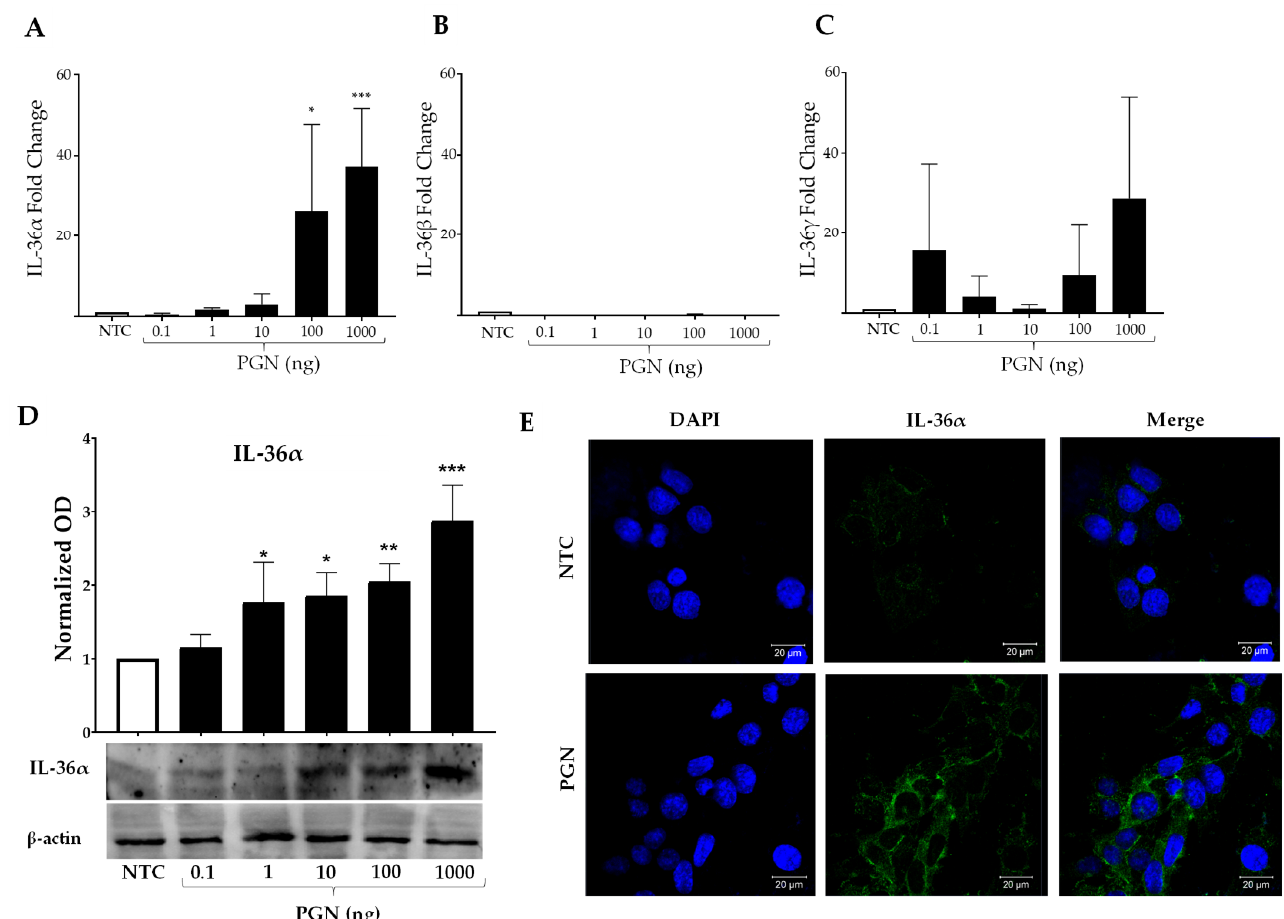
Figure 3. The stimulation of MCs with PGN generates the production of IL-36 α . MES SV40 cells (1.5 × 10 6 ) were stimulated in 2 mL of medium containing different amounts of PGN for 6 h, and ( A ) the IL-36 α ; ( B ) IL-36 β ; ( C ) IL-36 γ mRNA expressions were measured. The expression was normalized against Actb, and the fold change was calculated in comparison with the respective non-stimulated control (NTC). ( D ) Mesangial cells were stimulated under similar conditions, and total proteins were extracted for WB. The intensity of bands was normalized against β -actin, and the fold change was calculated. E) Representative IF image of IL-36 α (green stained) in MCs stimulated with 1 µg of PGN for 6 h. Results were obtained from at least 3 independent experiments and are presented as mean ± SD. Data were analyzed with one-way ANOVA followed by Dunnett´s analysis. *